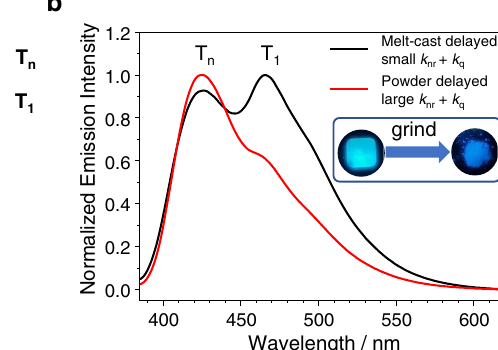
Fig. 4 | The proposed dual RTP mechanism and RTP(T n )/RTP(T 1 ) ratiometric response towards mechanical grinding. a Jablonski diagram of BPBF 2 -PhB after- glow system; b Delayed emission spectra (1ms delay) of 3 -PhB-0.1% melt-cast